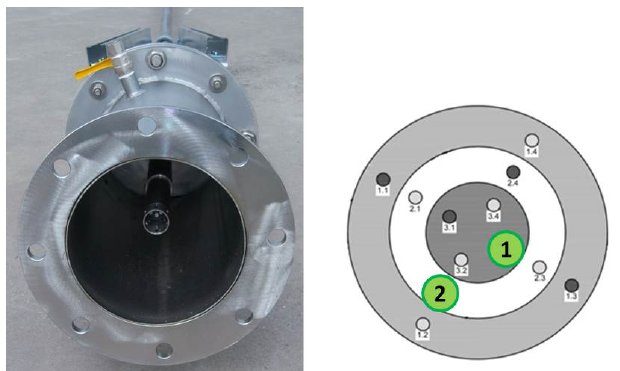
Figure 9. Left: multi-sensor probe in the device to install on a gas- tight lock; right: schematic drawing of the two used fermenter en- tries by means of gas-tight